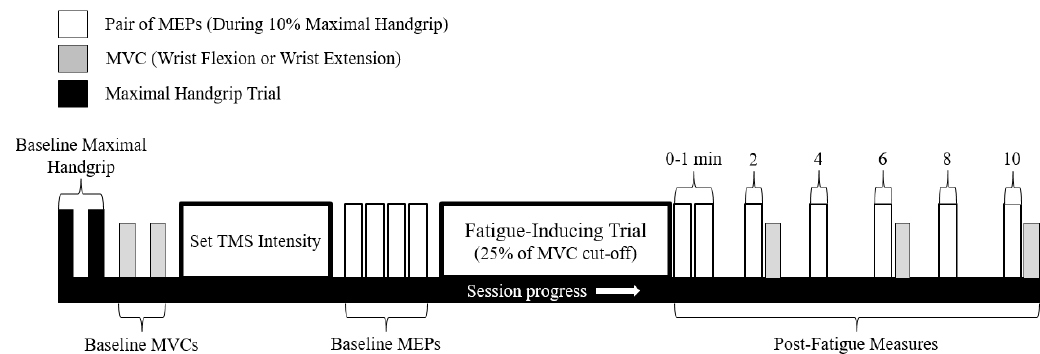
Figure 2. Schematic of the experimental protocol. This protocol was repeated for both the wrist flexion fatigue session and the wrist extension fatigue session (separated by 96 h minimum). The black bars represent the two maximal grip trials performed at the start of the collection. Grey bars represent wrist flexion/extension MVCs (performed on separate days), while white bars represent two MEPs (elicited during 10% of maximal handgrip force).